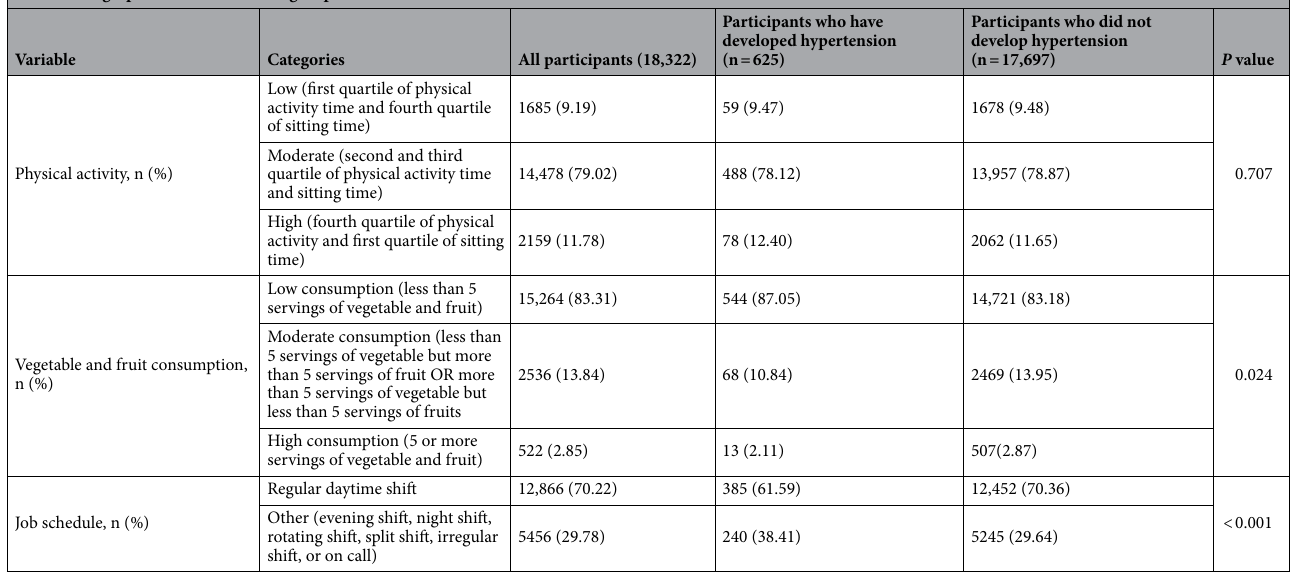
Table 1. Baseline characteristics of study participants according to the status of developing hypertension or not. “–” indicates cell frequency <